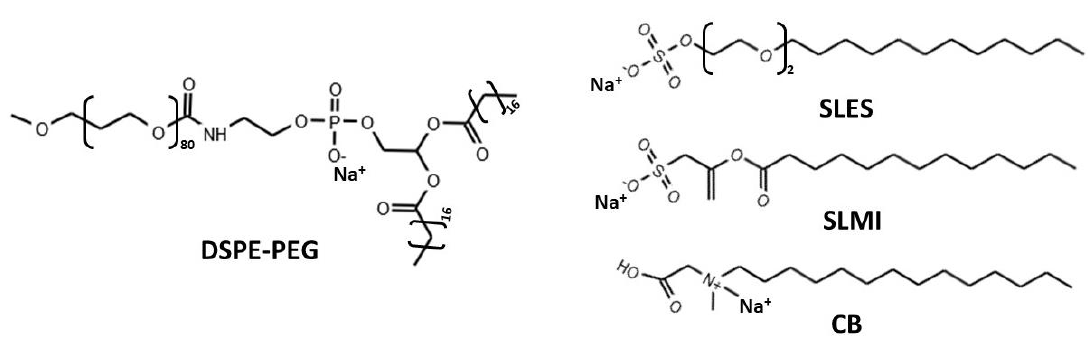
Figure 1. Molecular structures of the DSPE-PEG and the three surfactants.